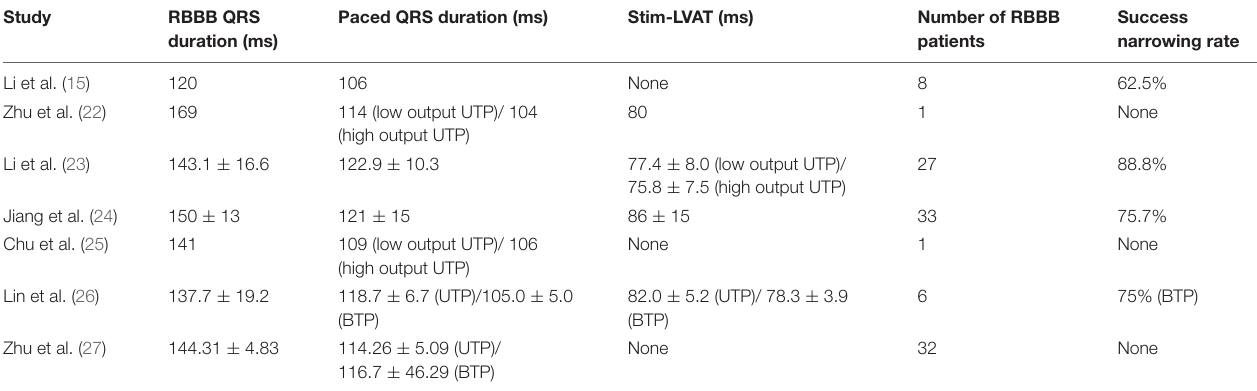
TABLE 1 | Summary of studies demonstrating paced QRS narrowing during LBBP in RBBB.